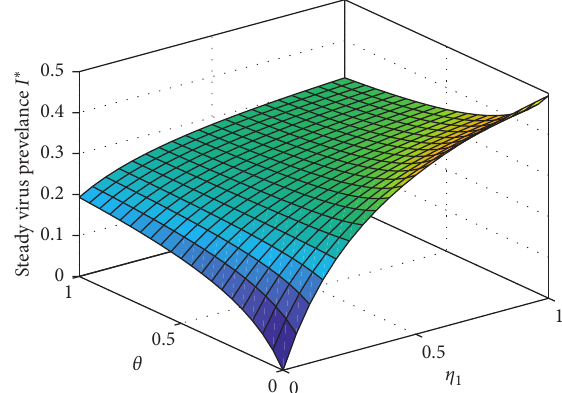
Figure 9: An illustration of the effect of α and ε on I ∗ on I ∗ . 1